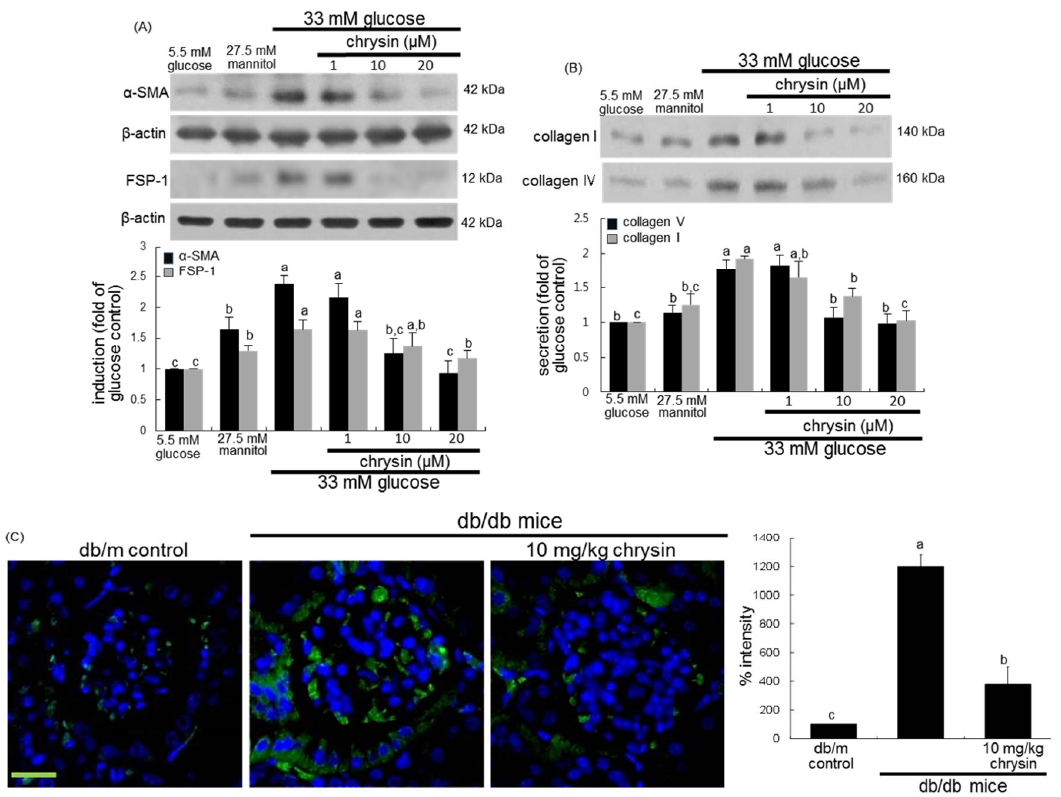
Figure 2. Inhibition by chrysin of glucose-induced cellular induction of α-SMA and fibroblast specific protein (FSP)-1 ( A ) and secretion of collagen I and collagen IV ( B ) in mesangial cells and α-SMA induction in mouse glomeruli ( C ). Human renal mesangial cells were challenged for 3 days with 5.5 mM glucose, 5.5 mM glucose plus 27.5 mM mannitol as osmotic controls or with 33 mM glucose in the absence and presence of 1–20 μM chrysin. Cellular induction of α-SMA and FSP-1 and secretion of collagen I and collagen IV into culture media were measured by using Western blot analysis with a primary antibody against α-SMA, FSP-1, collagen I or collagen IV ( A , B ). The bar graphs (mean ± SEM, n = 3 independent experiments) in the bottom panel represent densitometric results obtained from Image analysis. β-actin protein was used as an internal control. Diabetic mice were orally administrated with 10 mg/kg chrysin for 8 weeks. The α-SMA induction in diabetic mouse glomeruli was visualized as FITC-green staining and nuclear counter-staining was done with the blue stain DAPI ( C ). Scale bar = 25 μm. The relative staining intensity was measured and the respective values are expressed as mean ± SEM ( n = 4 mice in each group). Values in bar graphs not sharing a same lower case indicate significant different at p < 0.05.